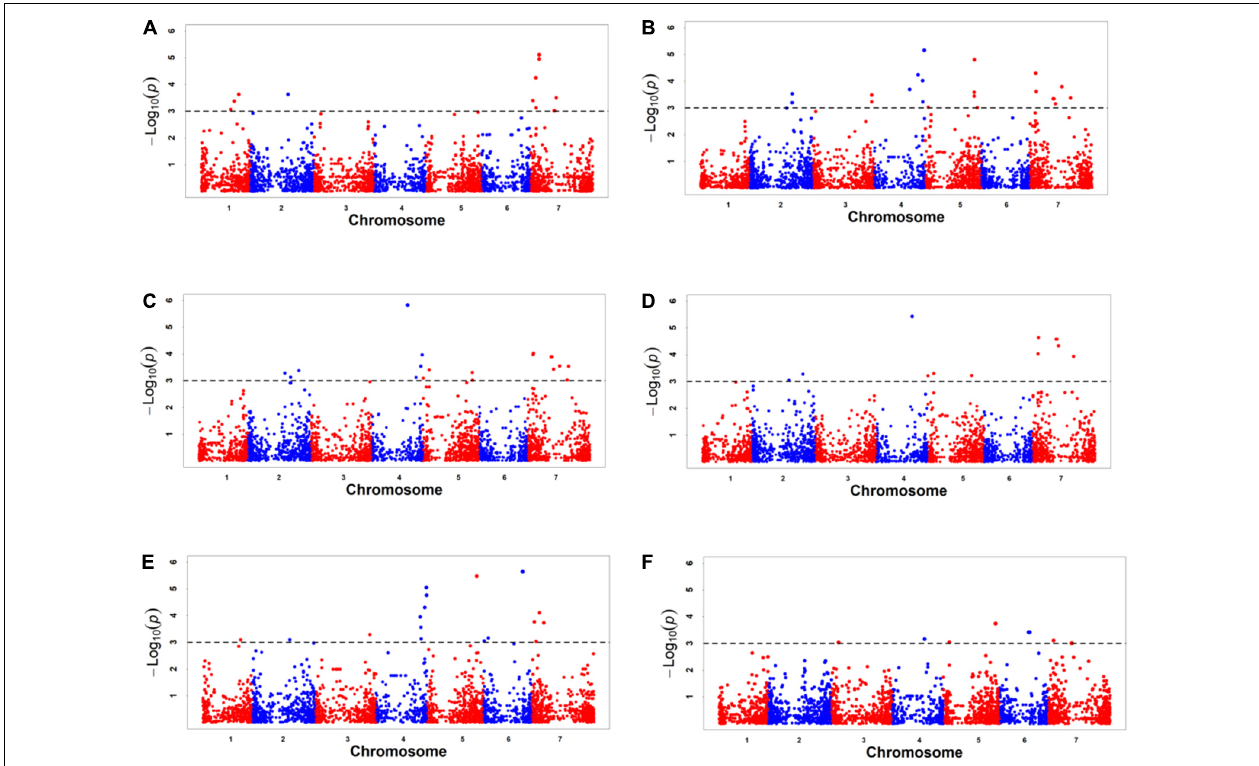
FIGURE 2 | Manhattan plots of genome-wide association study results for six kernel traits based on BLUP value. (A) KL, kernel length, (B) KW, kernel width, (C) KV, kernel volume, (D) KSA, kernel surface area, (E) KWL, kernel width to length ratio, (F) HKW, hundred-kernel weight.